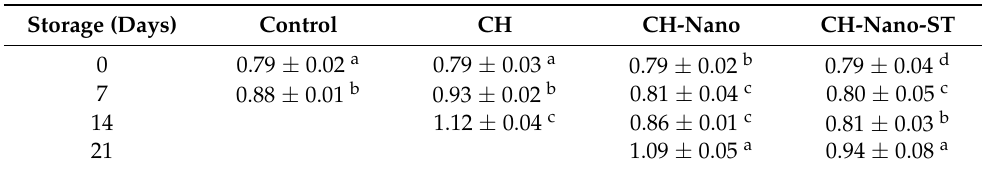
Table 1. Bacterial contamination of Salmonella spp. isolated from coated cucumber samples during storage at 10 ◦